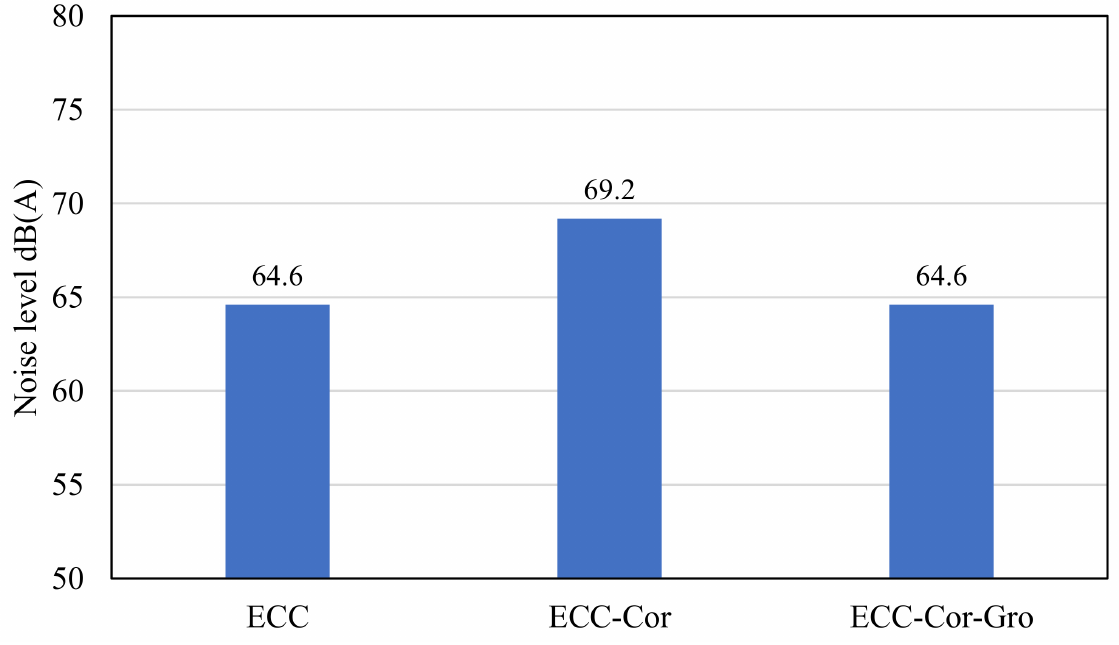
Figure 9. Noise level dB(A) comparison of SHCC, SHCC-Cor, and SHCC-Cor-Gro. SHCC-Cor-Gro represents a potential solution for resilient roadways with pavement made of SHCC. The modification of SHCC-Cor by introducing grooves (SHCC-Cor-Gro) successfully reduced the sound level coming from the vibration. The sound level from the air parameter was slightly reduced, mainly in the frequency from 315 to 1250